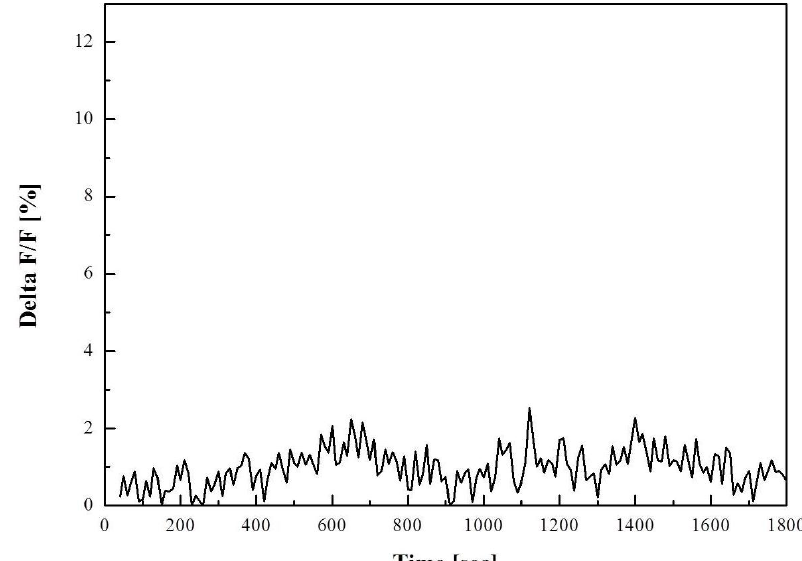
Figure 8. The delta functions of cultured neuroblastoma cells taken during 30 min after injection of 3 μL of